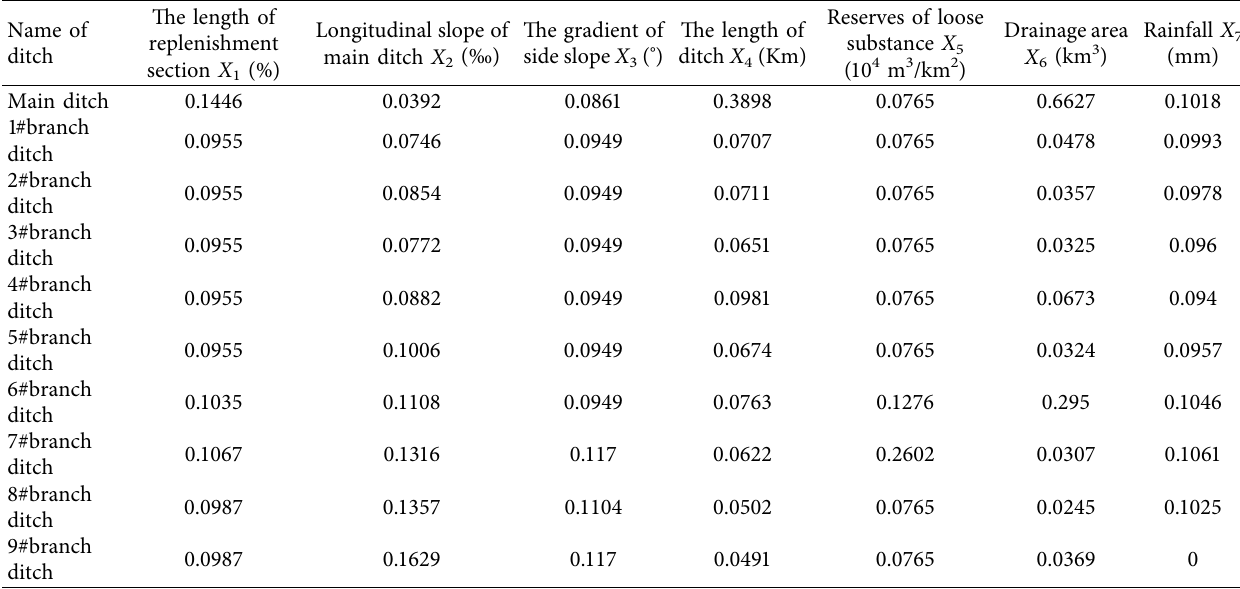
Table 3: The synthetic parameters of debris flow.